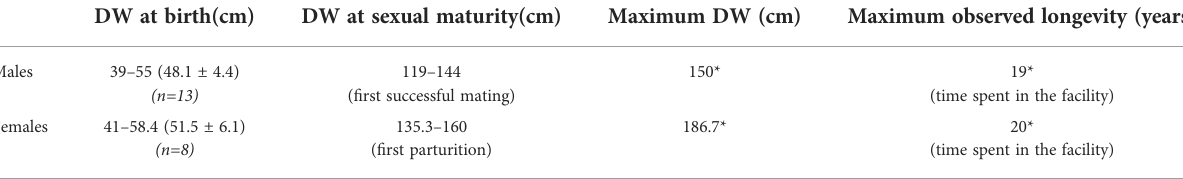
TABLE 2 Summary of the participating AZA aquariums ’ data.